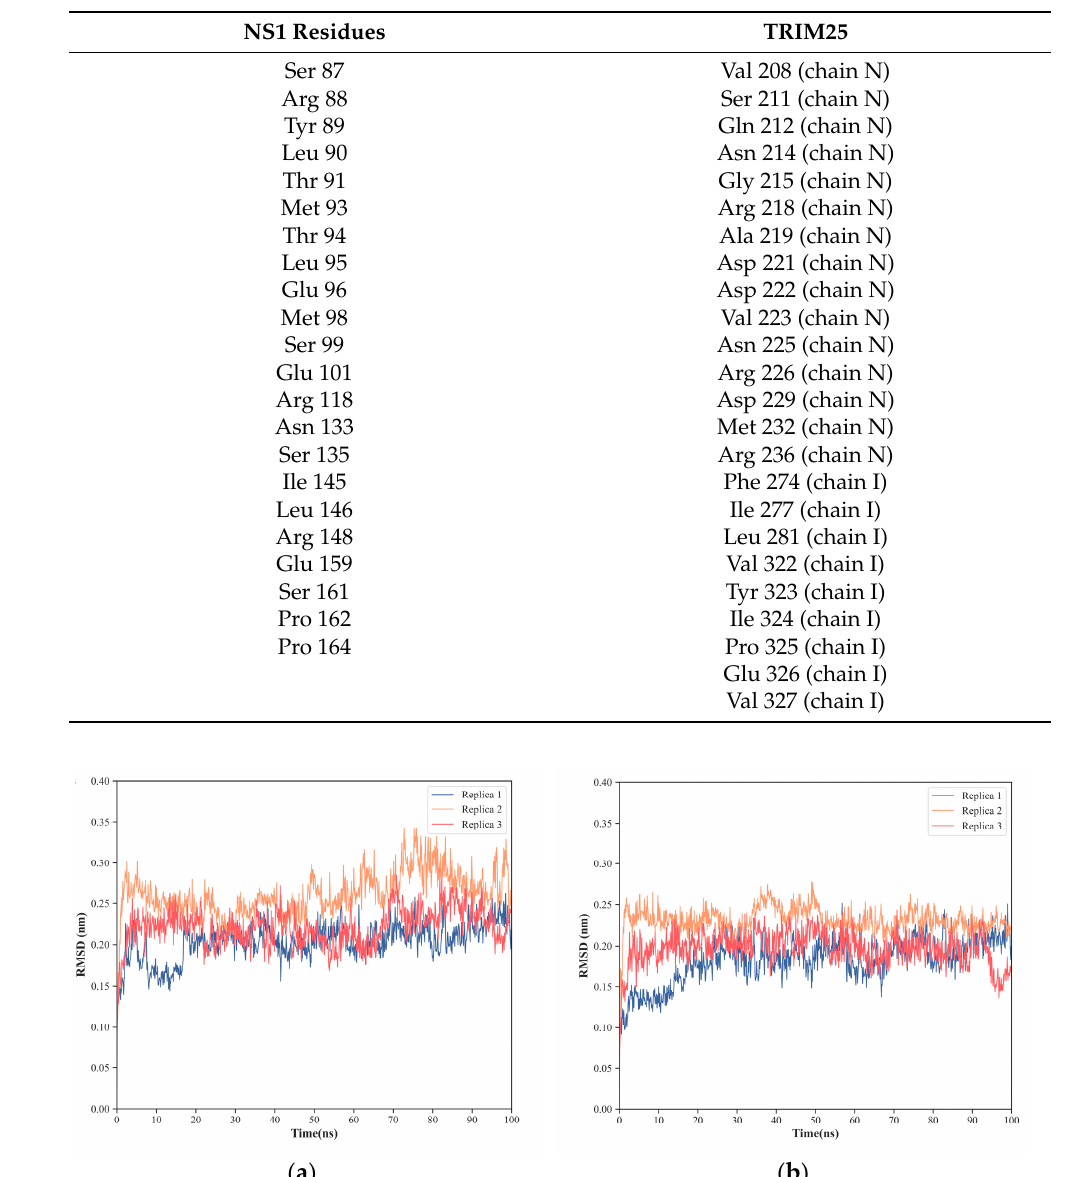
Table 2. Amino acid residues constituting the interfacial region in the NS1-TRIM25 complex.